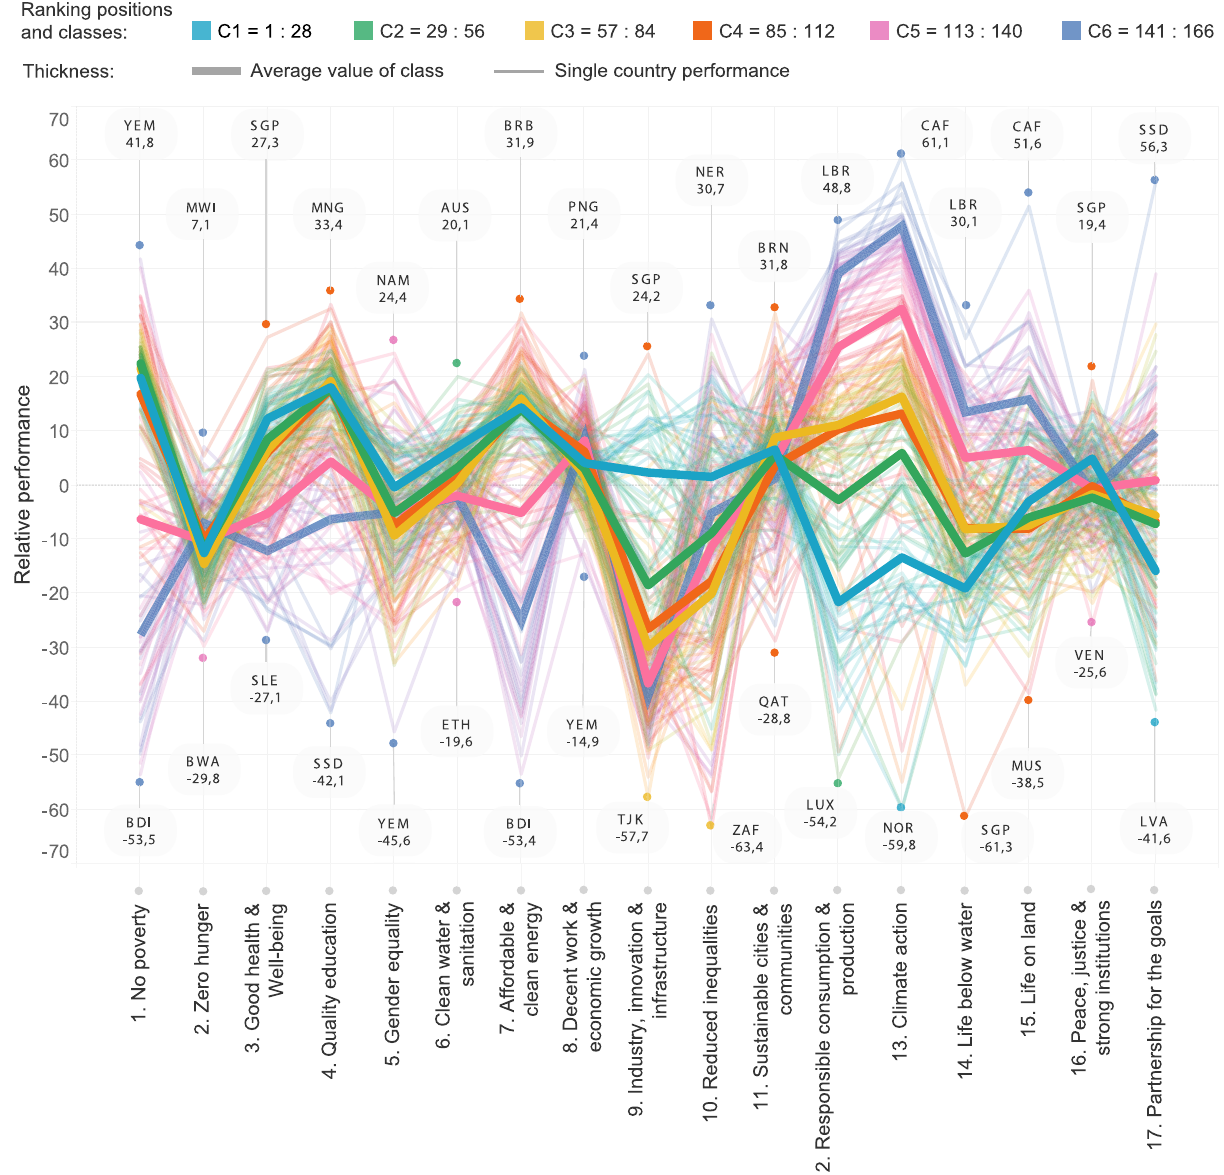
Figure 2. The spectra of countries’ relative performances, obtained as P cg − ( k c / 17 ) . Countries are first ranked and then clustered according to their average performance (i.e., the SDG Index or, equivalently, their degree). Based on the ranking positions, we define six classes of performance: light blue (countries in positions 1 − 28 ), green ( 29 − 56 ), yellow ( 57 − 84 ), magenta ( 85 − 112 ), pink ( 113 − 140 ) and violet ( 141 − 166 ). The classes’ average spectra of relative performances are shown in thicker lines. The top and bottom relative performers in each Goal are pointed out, and their performance value is color-coded as their corresponding class. The figure has been generated using Tableau 2020.3, [https:// www. table au.